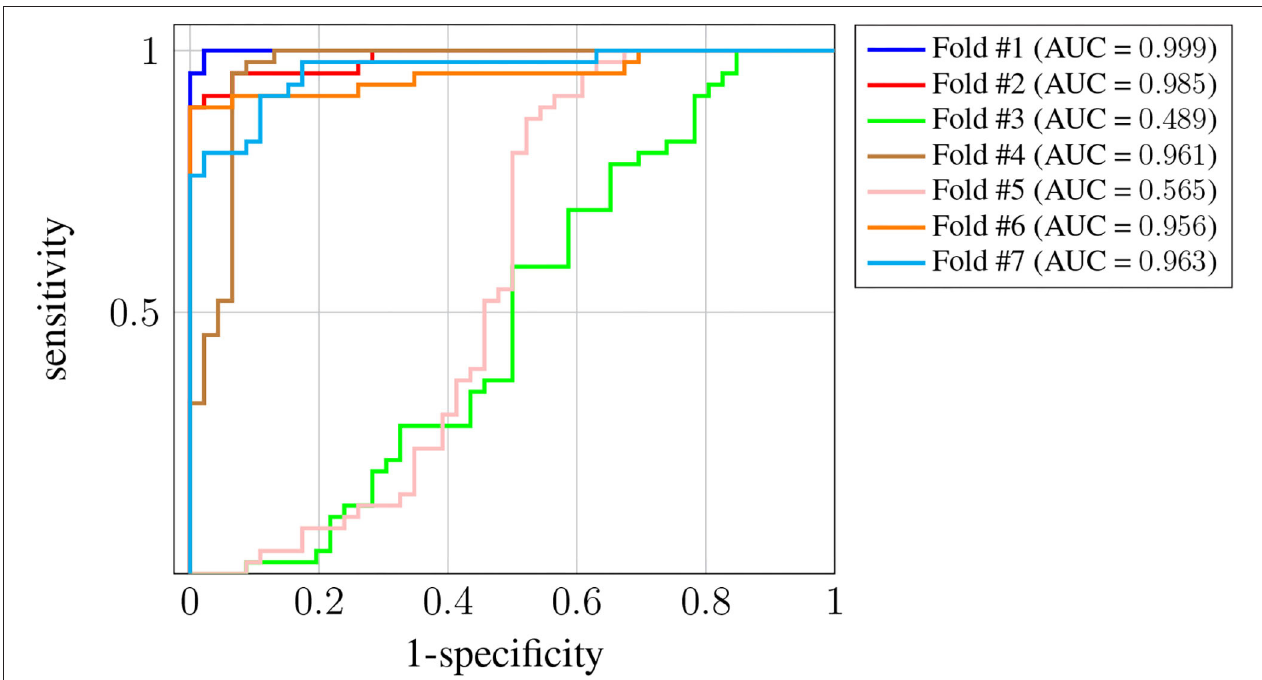
FIGURE 6 | ROC curves for Leave-p-Subjects-Out cross-validation. Each curve corresponds to a different fold, and the attained AUC is, in every case, shown in the legend.